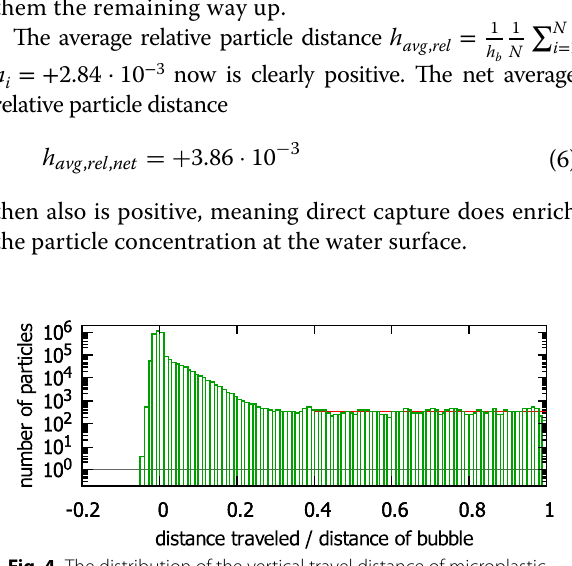
Fig. 4 The distribution of the vertical travel distance of microplastic particles relative to the travel distance of the bubble. Here particles stick to the bubble. The bubble picks up new particles along the entire distance of travel and transports them to the top, visible as a plateauing distribution highlighted by the red